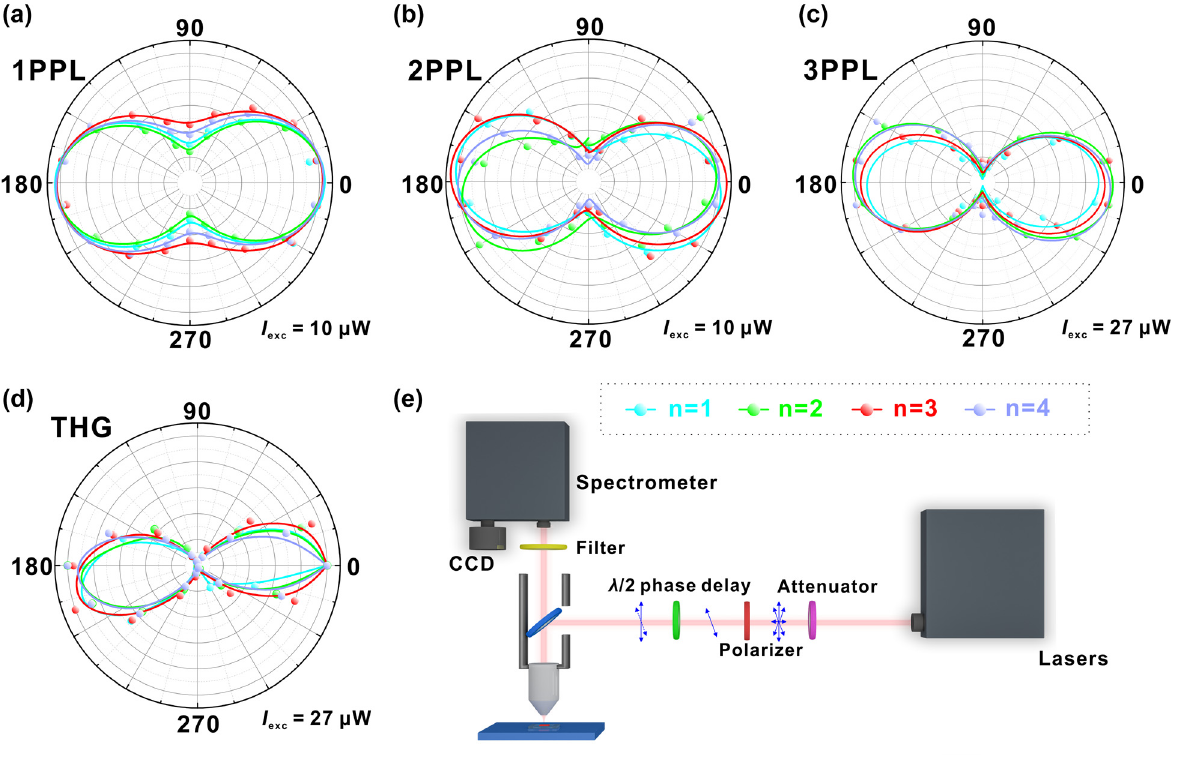
Figure 3: Incident light polarization dependence of 2D RPPs ’ different optical processes. (a) Incident light polarization dependence of single-photon photoluminescence (1PPL). Excitation wavelength is 400 nm. (b) Incident light polarization dependence of 2PPL. Excitation wavelength is 800 nm. (c) Incident light polarization dependence of 3PPL. Excitation wavelength is 1500 nm. (d) Incident light polarization dependence of THG. Excitation wavelength is 1800 nm. (e) Schematic diagram of polarization dependence measurement